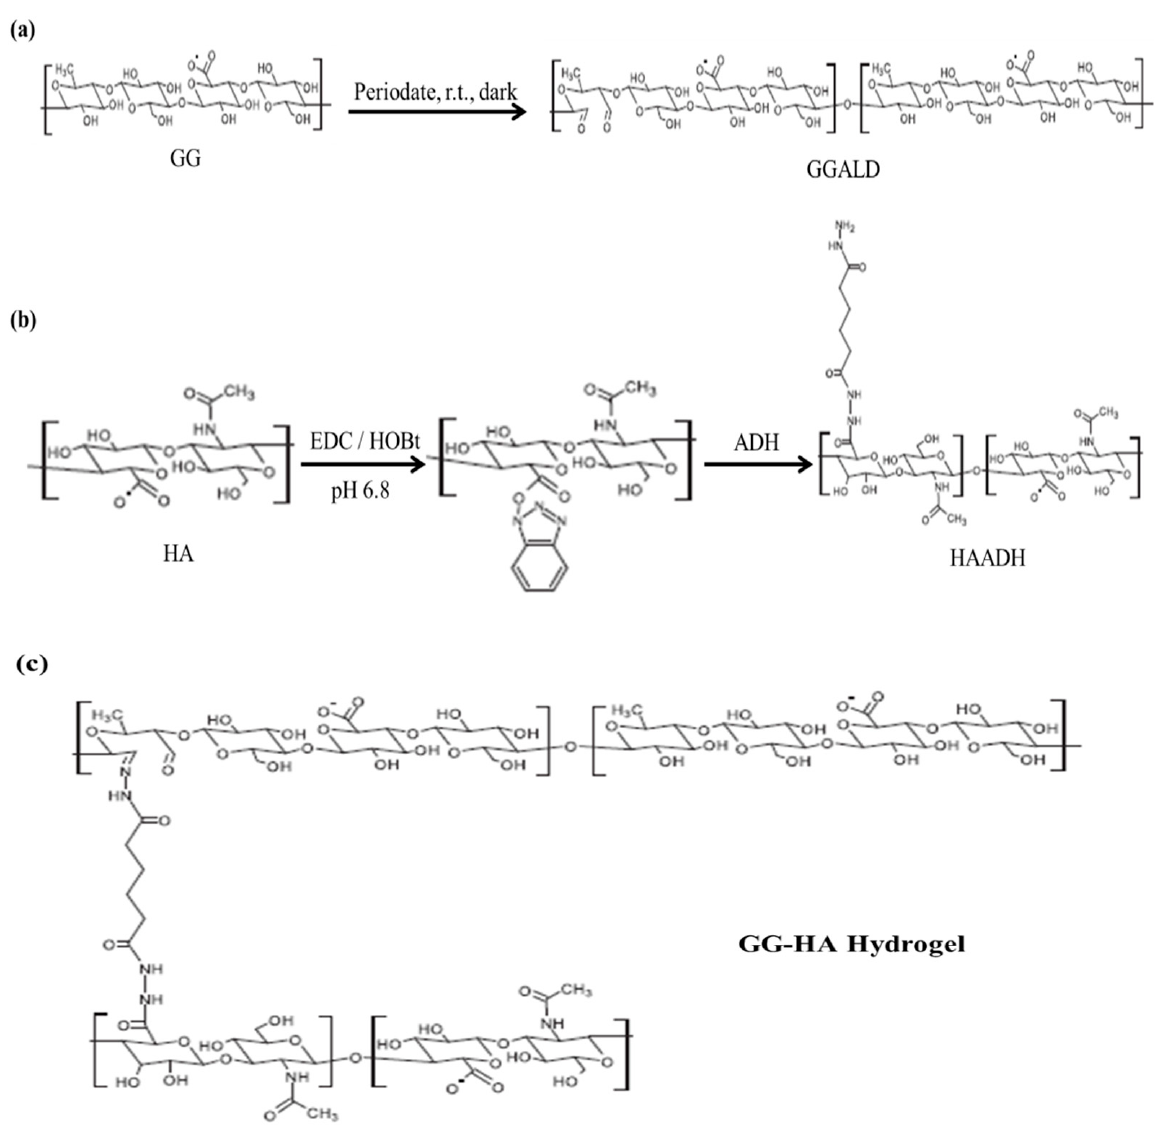
Figure 8. ( a ) Aldehyde-modification of GG (GGALD), ( b ) hydrazide-modification of HA (HAADH), and ( c ) The chemical structure of hydrazone crosslinked GG-HA hydrogels (adapted with permission from Karvinen et al., 2018).